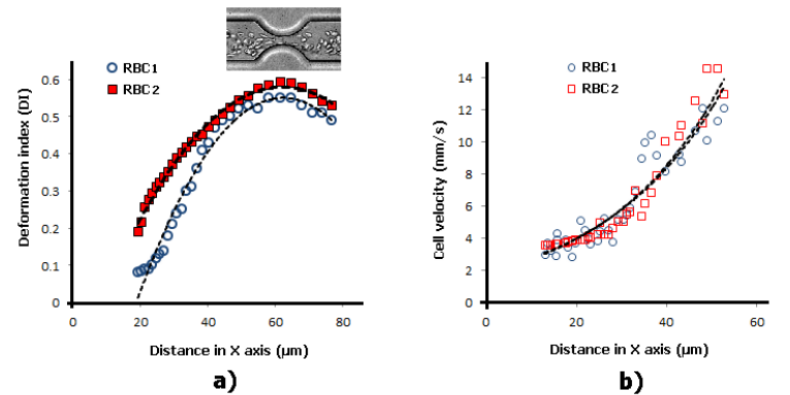
Figure 6. Individual RBCs ( a ) DI and ( b ) velocity flowing through a smooth contraction microchannel for the same flow rate. The X axis correspond to the main flow direction.